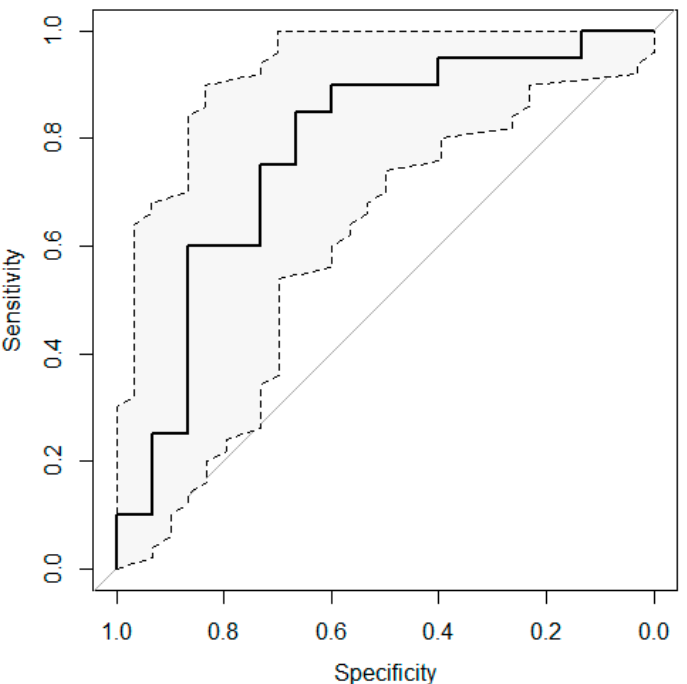
Figure 2. Receiver operating characteristic (ROC) curve calculated for the variation of the cluster shade feature when a BED value of 40 Gy is reached The ROC curve is reported in continue line, the extremes of the 95% confidence interval are reported in dot lines. Table 3. Results of the univariate analysis performed using the Wilcoxon Mann–Whitney (WMW) test between five clinical variables (cT, cN, cM, age, and BED) and two outcomes (one-year local control, 1yLC; and one-year overall survival, 1yOS).